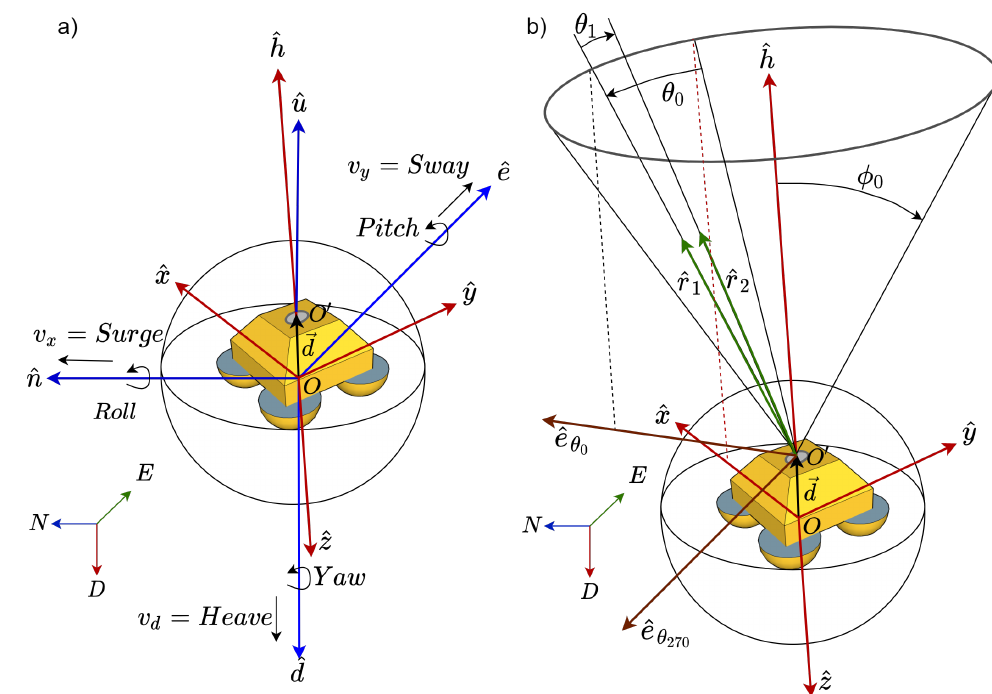
Figure 3. Schematic of the motion geometry of the FDWL buoy. ( a ) The moving-body coordinate system (red arrows) and the fixed coordinate system (blue arrows). ( b ) The LiDAR scanning cone and LiDAR pointing direction (green arrows) in relation to the XYZ coordinate